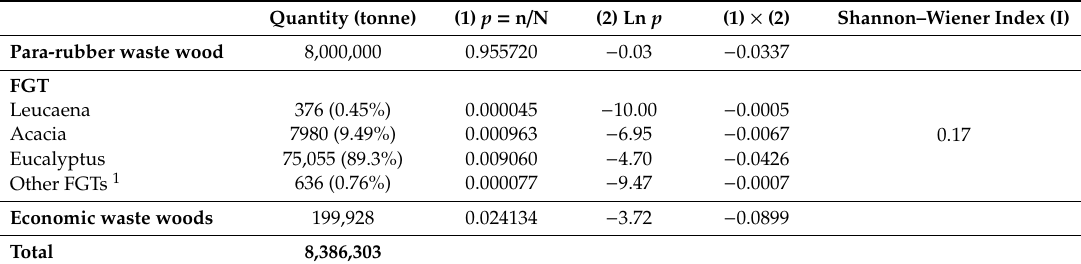
Table 8. Shannon–Wiener index of raw materials for wood pellet production in 2018.